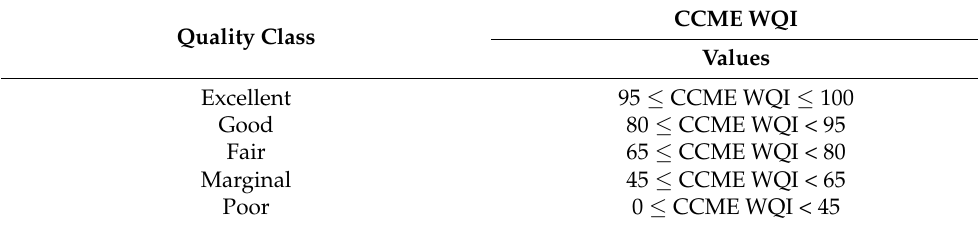
Table 4. Surface water quality classes according to CCME WQI values